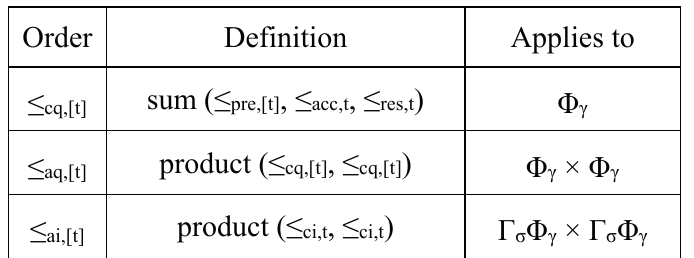
Table 2. Orders for